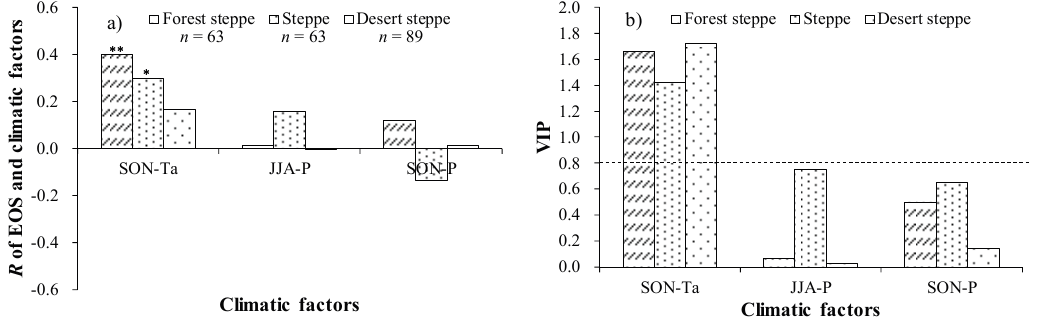
Figure 6. Correlation ( a ) between EOS and climatic factors for three grassland types and VIP ( b ) for considered variables. * indicates the significance level of 0.05 and ** indicates the significance level of 0.01. The n is the number of phenological records for EOS.